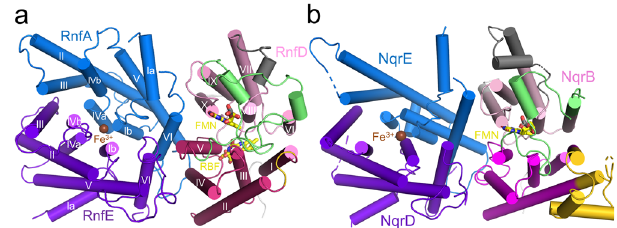
Fig.3|Thestructureoftheintegralmembranesubunits.a RnfADEviewedfrom the extracellular side onto the membrane. RnfA (sky blue) and RnfE (purple) are inversely arranged and superimposable via a two-fold axis parallel to the viewing direction approximately penetrating the iron. The TM helices are drawn as cylin- ders. RnfD is built up of two inverse fi ve-helix moieties (red-violet and pink) fused byanexpandedlinker(lime).ThecentrallypositionedFe 3+ RnfAE andRBFarelocated at the cytoplasmic and FMN RnfD at the extracellular monolayer sides, respectively. Helices I and IV of RnfA and RnfE are separated into two half-helices that are displacedandkinkedrelativetoeachother. b NqrEBDintheorientationofRnfADE. The arrangement and length of the TM helices of RnfADE and NqrEBD are similar. MajordifferenceslocalizedinRnfD/NqrBincludetheextracellularinsertion(gold), the fi ve-helix linker (lime), and the linker (gray) between helices VII (206:223; Rnf nomenclature) and VIII